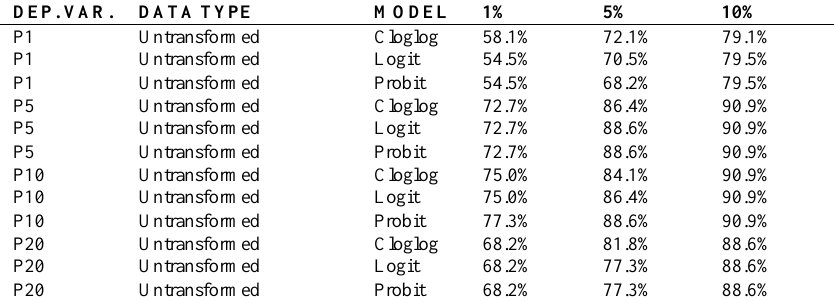
Table 3. The LR test results for the individual assets analysis DEP. VAR.